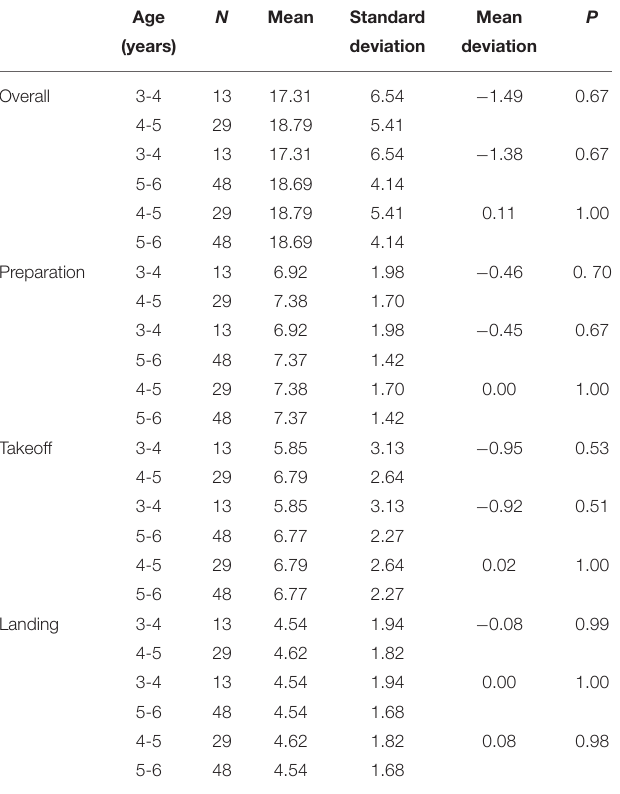
TABLE 7 | Post-hoc analysis of the overall scores of children after completion of tasks with varying difficulties.